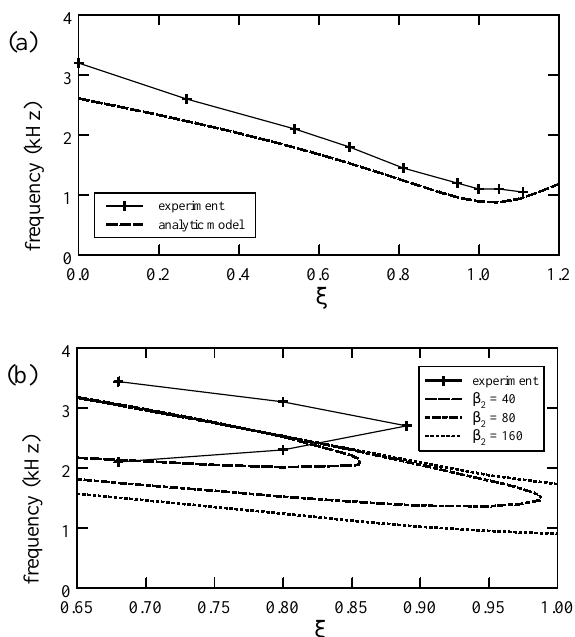
FIG. 16. (a) Observed bunch oscillation frequency as a func- tion of j , for active Landau-cavity operation with the LF20 lattice and a ring current of 1.5 mA. Analytic modeling of the coupled-dipole Robinson frequency is also shown. (b) Bunch oscillation frequencies observed for active Landau-cavity opera- tion with the LF20 lattice at a ring current of 155 mA. Instability occurs when the frequencies converge for j (cid:1) 0.89 .